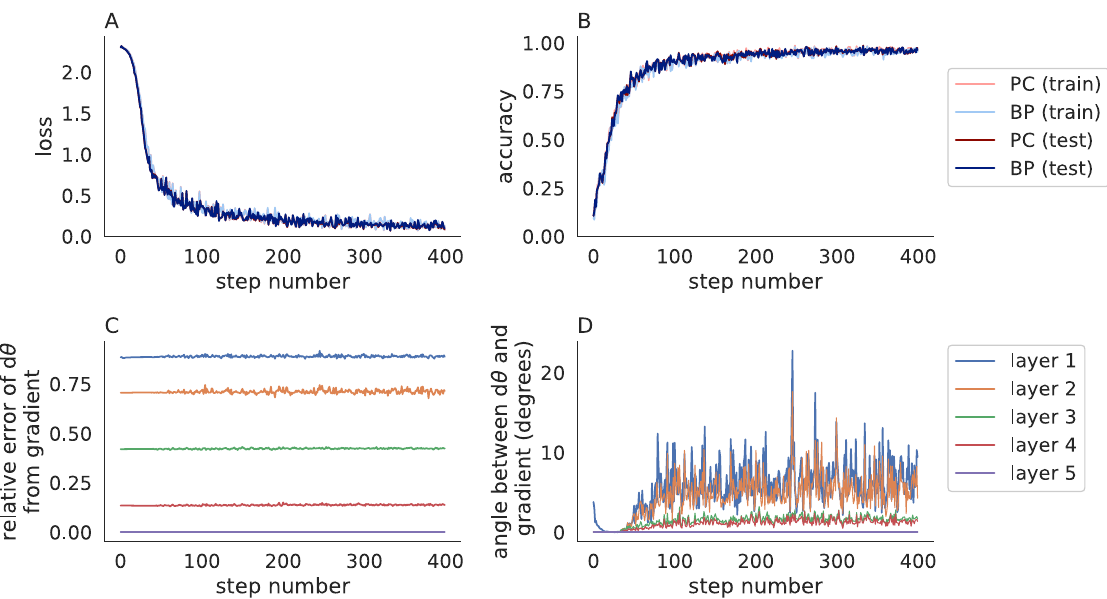
Fig 3. Predictive coding modified by the fixed prediction assumption compared to backpropagation in a convolutional neural network trained on MNIST. Same as Fig 1 except Algorithm 3 was used (with η = 0.1 and n = 20) in place of Algorithm 2. The accuracy of predictive coding with the fixed prediction assumption is similar to backpropagation, but the parameter updates are less similar for these hyperparameters.